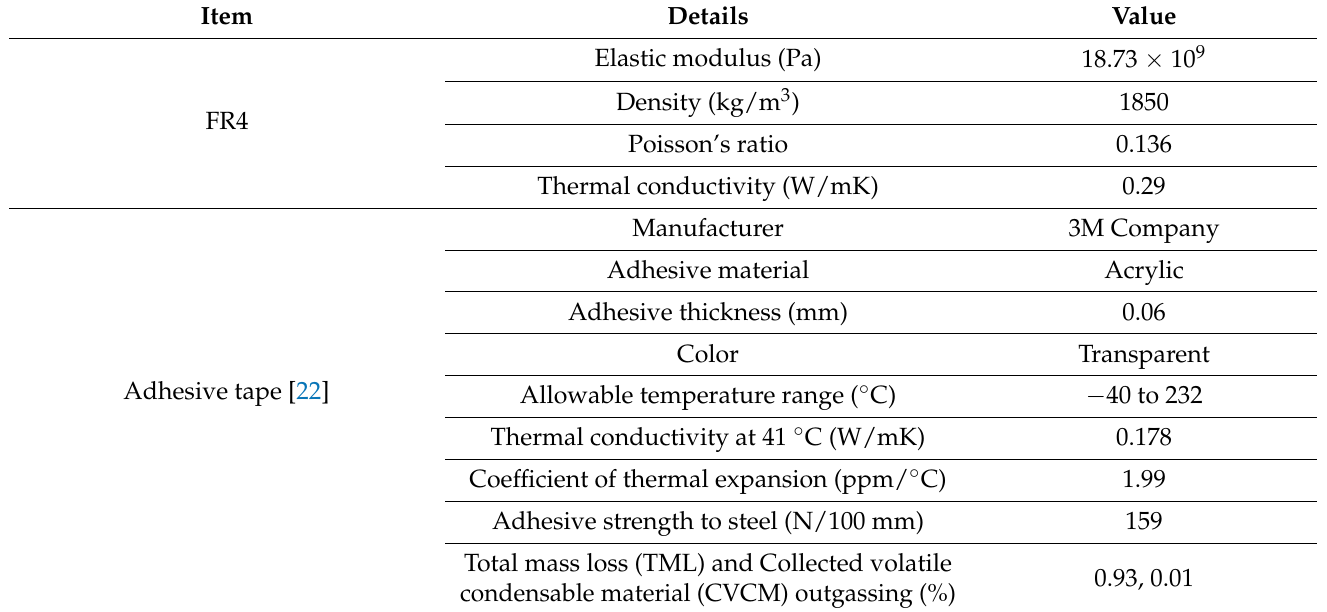
Figure 3. Configurations of a highly damped deployable solar panel module’s demonstration model: ( a ) stowed and ( b ) deployed. Table 4. Specifications of materials used in the solar panel